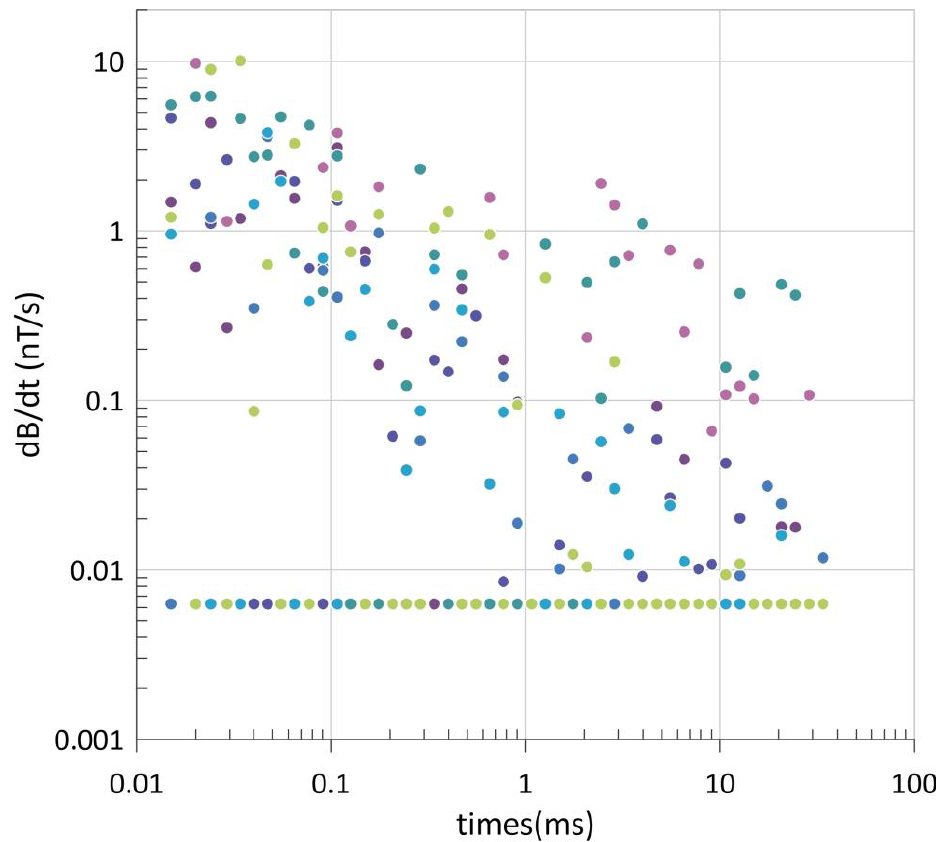
Figure 11. The noise level scatter diagram ground TEM measurement.